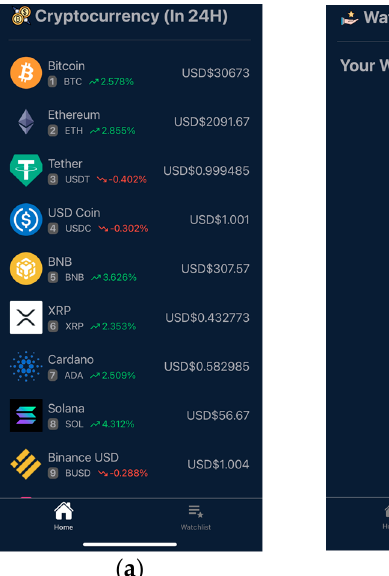
Figure 10. Prototype screen dump of the ( a ) homepage, ( b ) watchlist, and ( c ) detail page.